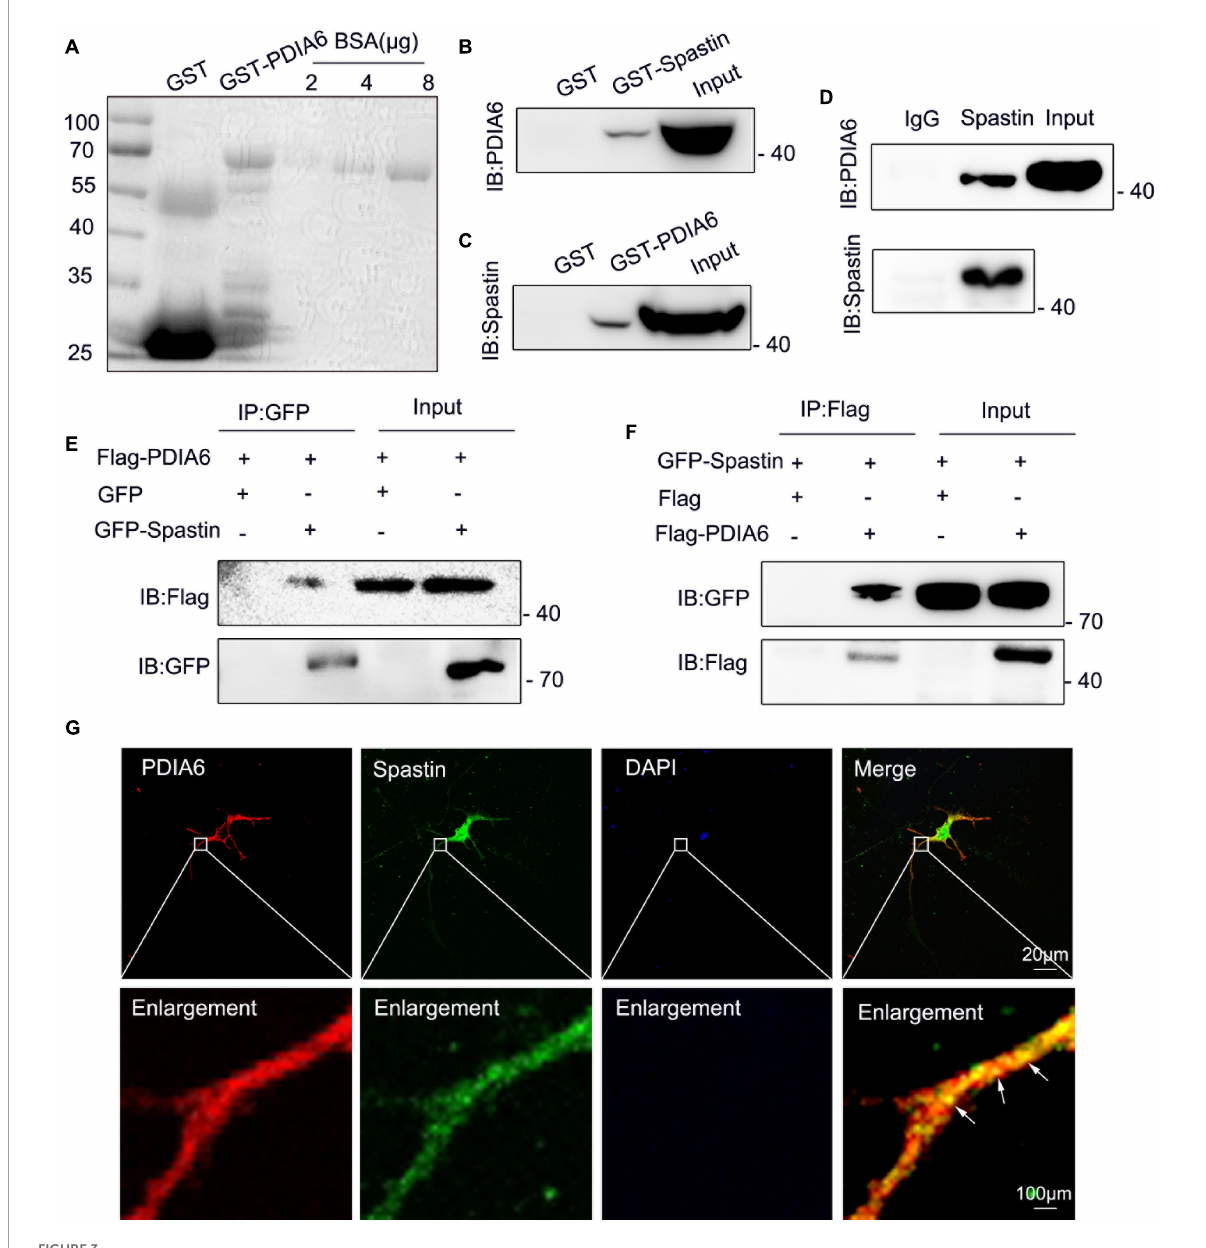
FIGURE3 PDIA6 and spastin physically interact with one another. (A) GST and GST-PDIA6 protein purification, with BSA serving as a loading control. (B,C) Following GST, GST-Spastin, and GST-PDIA6 pulldown of enriched rat brain lysates, PDIA6 and spastin were detected via Western immunoblotting. (D) Immunoprecipitation assays revealed the ability of PDIA6 and spastin to interact with one another, as proteins that co-eluted with anti-spastin could be detected by both anti-spastin and anti-PDIA6 staining. (E,F) COS-7 cells were co-transfected with GFP/Flag-PDIA6, GFP-Spastin/Flag-PDIA6, Flag/GFP-Spastin, or Flag-PDIA6/GFP-Spastin, after which GFP- and Flag-specific antibodies were used for immunoprecipitation. (G) Endogenous proteins within hippocampal neurons were detected using anti-PDIA6 (red) and anti-spastin (green). Co-localization between spastin and PDIA6 (yellow) is marked with arrows. Scale bars: 20 µ m and 100 µ m.